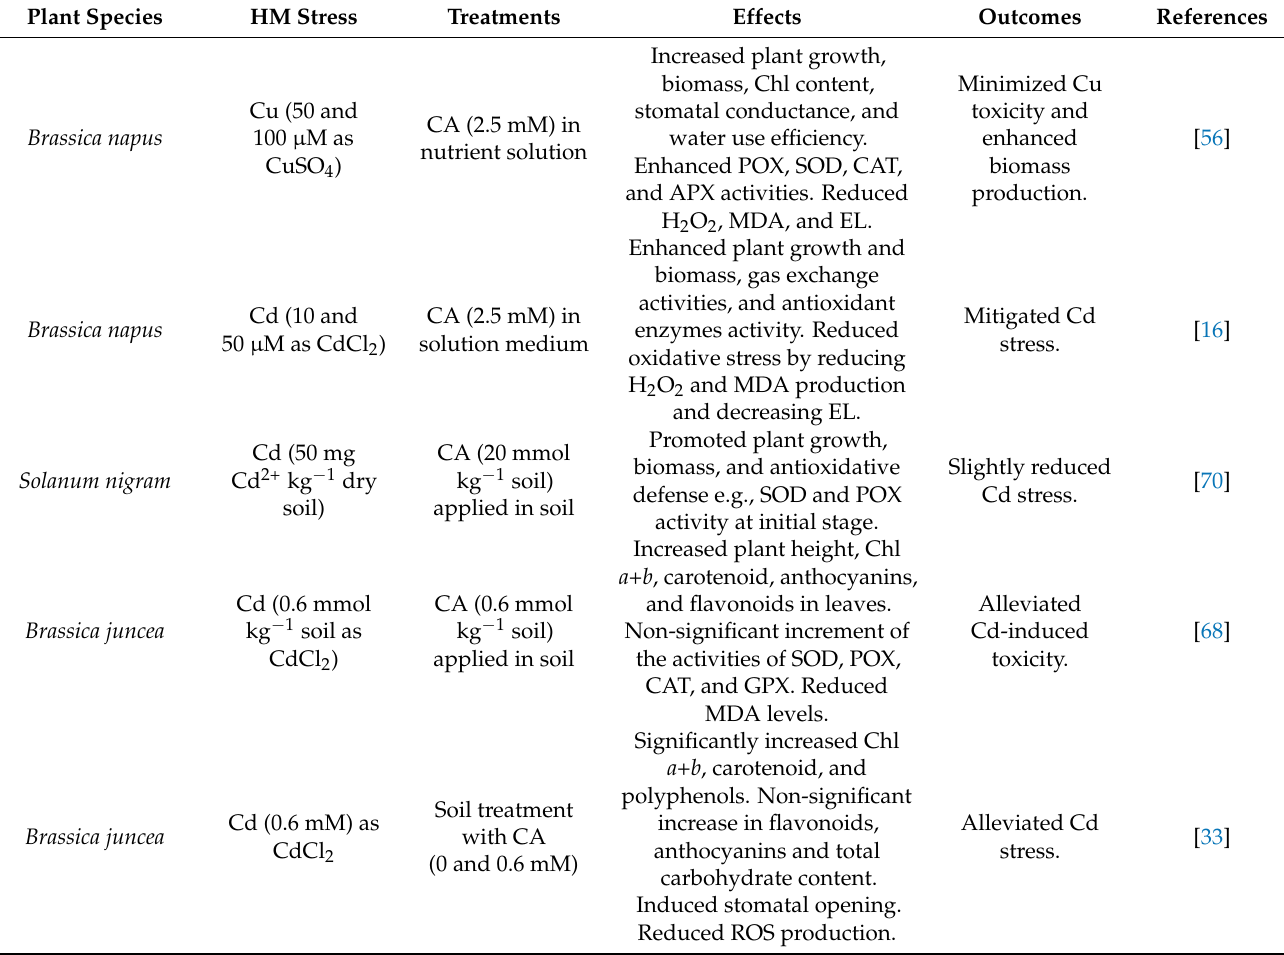
Table 4. Effectiveness of exogenous CA on mediating HM stress